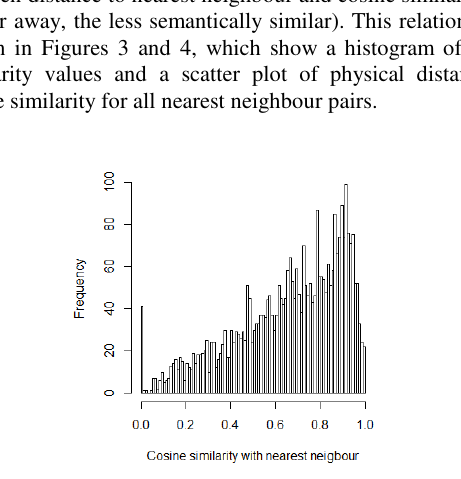
Figure 3: Histogram of the cosine similarities with the nearest neighbours